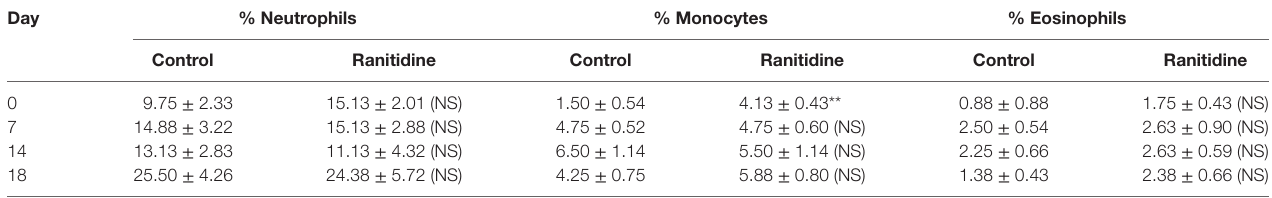
TaBle 2 | Percent of neutrophils, monocytes, and eosinophils of live leukocytes in circulation in E0771-GFP tumor-bearing C57BL/6 mice. Day % neutrophils % Monocytes % eosinophils control ranitidine control ranitidine control ranitidine 0